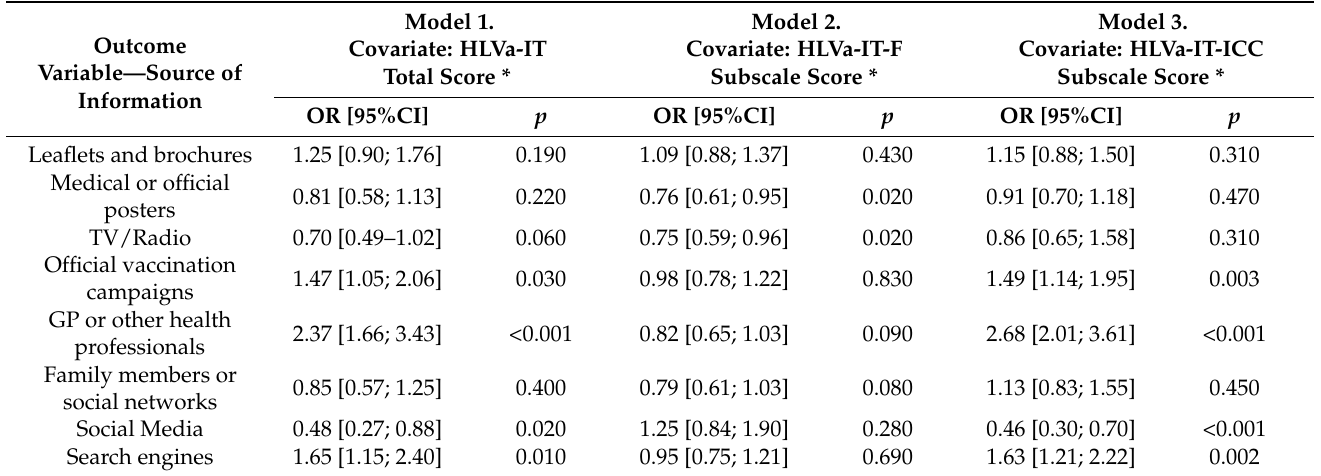
Table 5. Univariate logistic regression analyses: HLVa-IT score (total score, functional subscale score, and interactive/communicative/critical subscale scores) as a predictor of the main sources of information regarding vaccines and